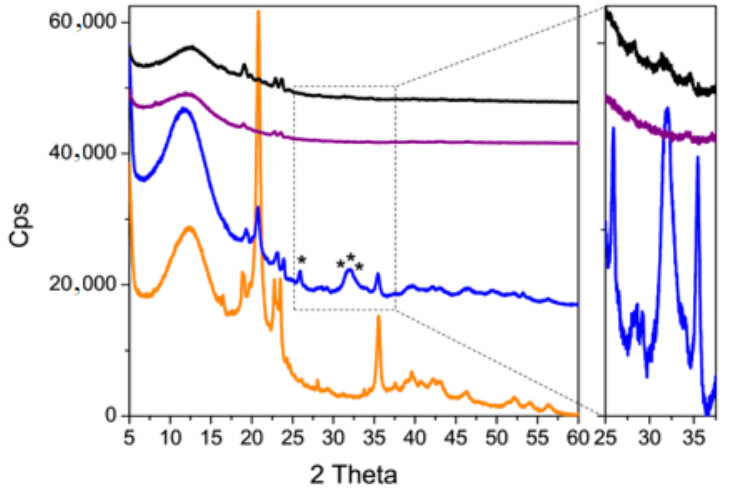
Figure 6. XRD patterns of NP NEG 1 (orange line), CaP-NP NEG 1B (blue line), NP POS 2 (purple line) and CaP-NP POS 2B (black line). Zoom: comparison of the patterns in the selected region. The asterisks * highlight the position of the peaks assigned to hexagonal hydroxyapatite.